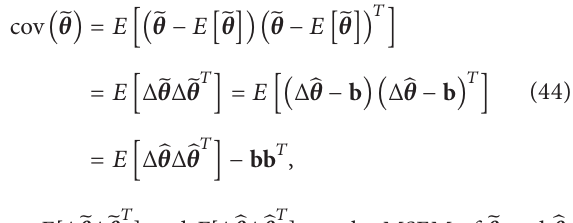
and FDOA estimates were generated by adding to the true values zero mean Gaussian noise. The covariance matrices of TDOA and FDOA were 𝜎 2 𝑟 R and 0.1𝜎 2 𝑟 R , where R was set to 1 in the diagonal elements and 0.5 otherwise. 𝜎 2 𝑟 is the TDOA noise power multiplied by the square of the signal propagation speed 3 × 10 8 m/s and the TDOA and FDOA noises were uncorrelated. The number of ensemble runs was 𝐾 = 10000 . The estimation bias and accuracy are